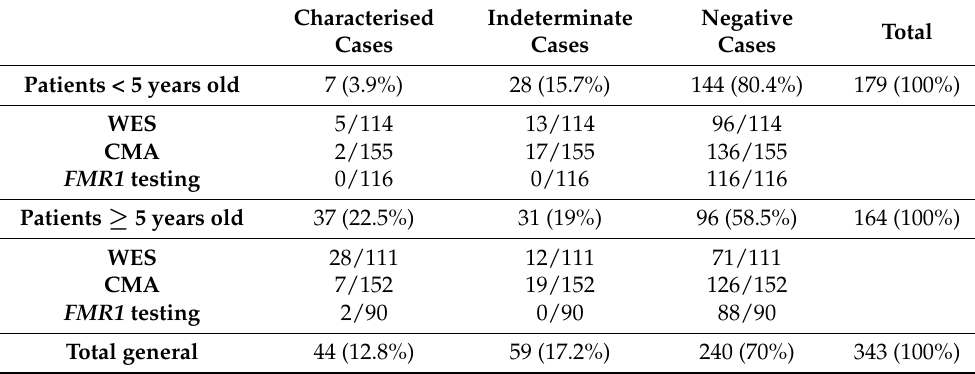
44 (12.8%) 59 (17.2%) 240 (70%) 343